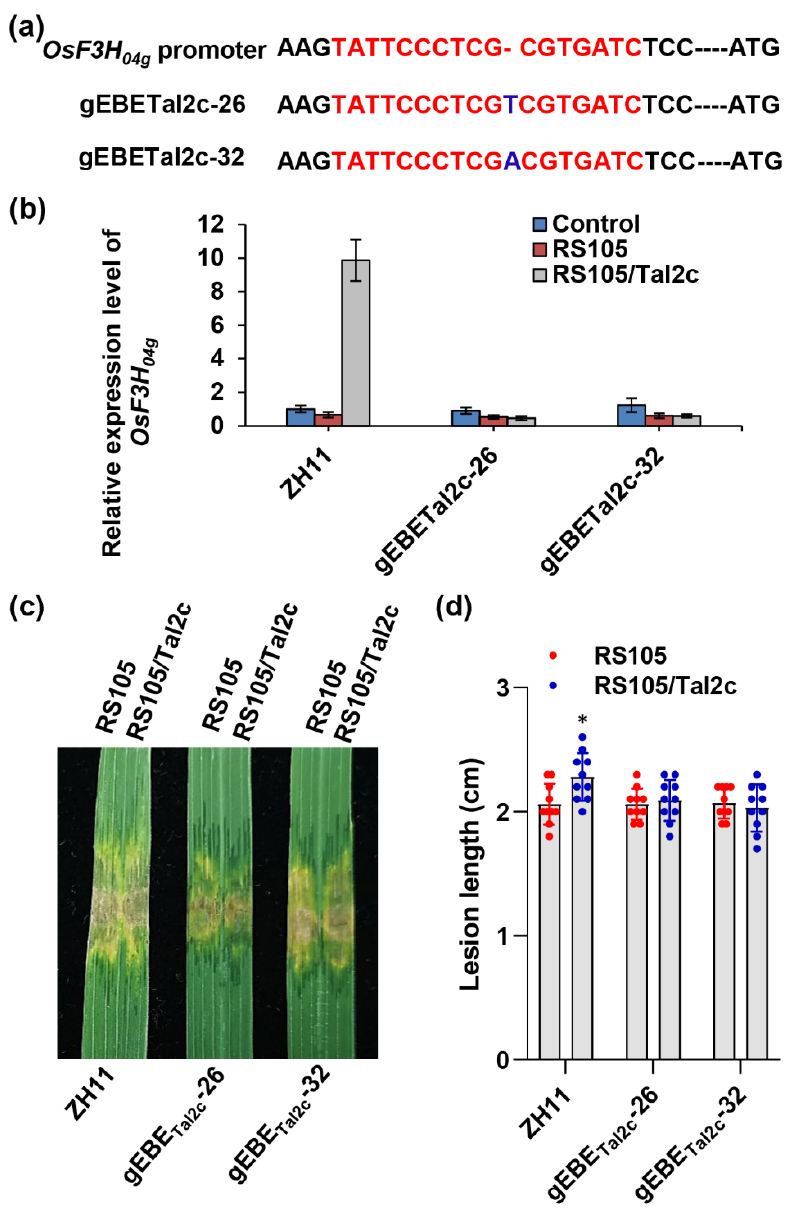
Figure 3. Gene editing of EBE in the OsF3H 04g promoter decreases rice susceptibility to Xoc strain RS105/Tal2c. ( a ) Genotypes of the EBE gene editing lines (gEBETal2c-26 and gEBETal2c-32) in the OsF3H 04g promoter. The sequences in red represent the Tal2c binding sites, and the bases in blue represent the insertion in the OsF3H 04g promoter. ( b ) Relative expression level of OsF3H 04g in ZH11, gEBETal2c-26 and gEBETal2c-32 lines at 4 dpi with RS105 and RS105/Tal2c. OsACTIN was used as an internal control. Data represent the means ± SD, n = 3. ( c ) Photograph of lesion expansion and ( d ) diagram of the lesion lengths in the ZH11, gEBETal2c-26 and gEBETal2c-32 lines at 14 dpi with RS105 and RS105/Tal2c. Data represent the means ± SD, n = 10. Asterisks represent significant differences between RS105 and RS105/Tal2c in ZH11 rice (* p ≤ 0.05, Student’s t- test).